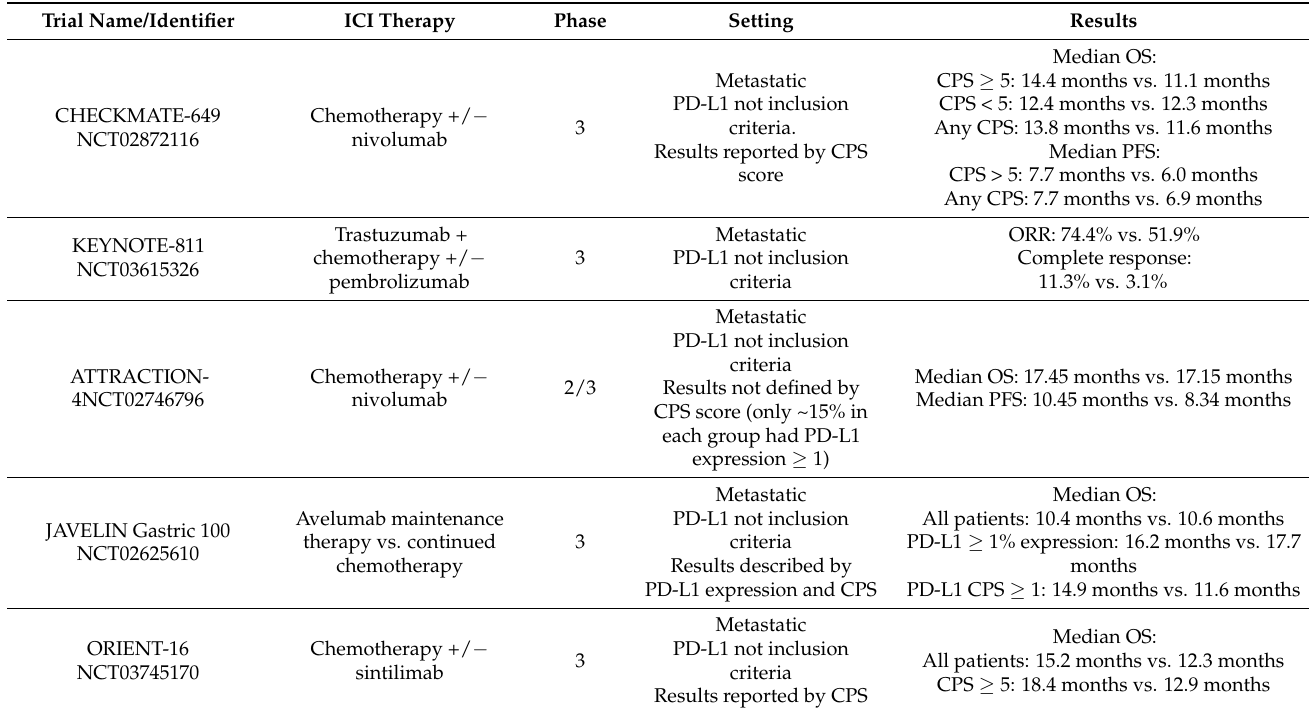
Table 2. Programmed-Death Ligand-l Expression with Immune Checkpoint Inhibitors in Gastric Cancer